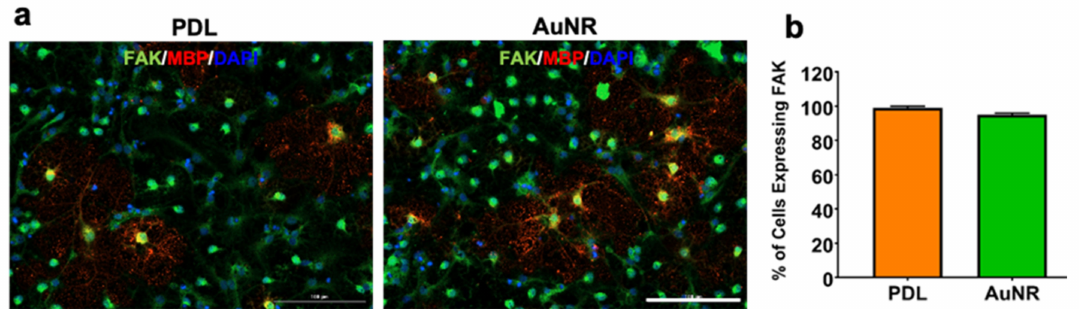
Figure 7. Determination of integrin activation in differentiated NPCs. ( a ) Fluorescence images of NSCs differentiated on PDL and AuNR substrates for one week and stained for FAK (green), MBP (red), and DAPI (blue). Scale bars: 100 µ m. ( b ) Quantitative comparison of the percentage of cells expressing FAK and